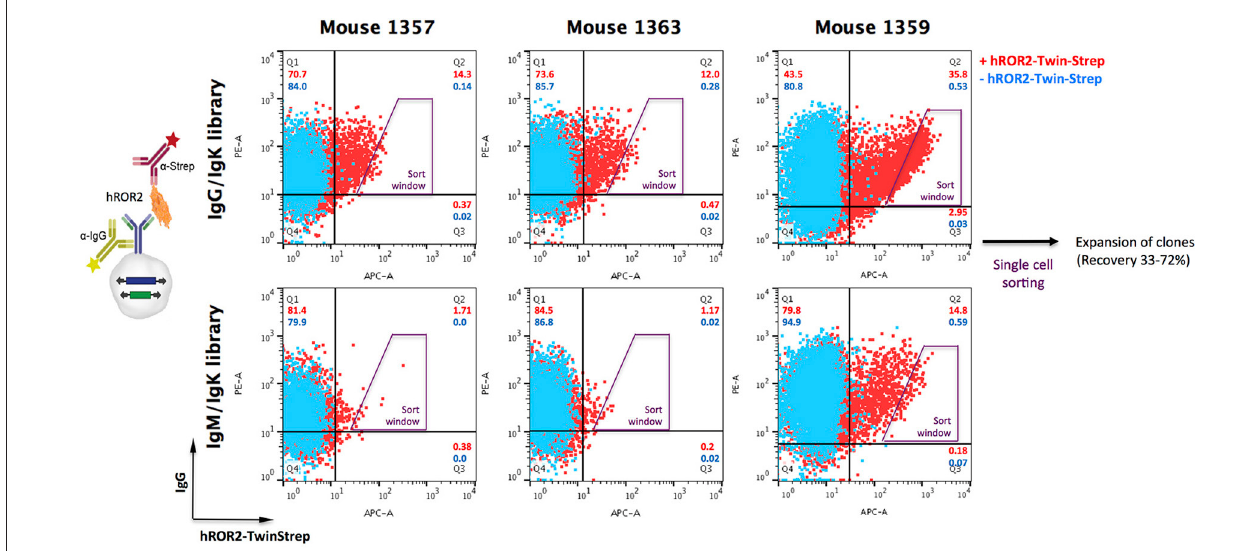
FIGURE 3 | Isolation of hROR2-binders from cellular libraries by FACS. Transpo-mAb-expression libraries were constructed by amplification of coding regions for human V H and V L domains with human variable domain specific primers using cDNA isolated from hROR2-ECD-Twin-Strep-specific splenocytes and cloning into transposable vectors, thereby fusing the variable domains in frame to the coding regions of either HC γ 1 or LC κ constant domains. By use of C γ 1 or C µ reverse primers, V H domain encoding libraries have been isolated from IgG or IgM expressing B lymphocytes. Following transposition of LC κ libraries paired with HC γ libraries (with V H domains from either IgG or IgM repertoires) into L11 progenitor B cells, these cellular libraries were screened for surface IgG expression and antigen-binding by simultaneous staining with an anti-human IgG-PE and hROR2-ECD-Twin-Strep detected by an anti-Strep-mAb coupled to a fluorochrome, respectively